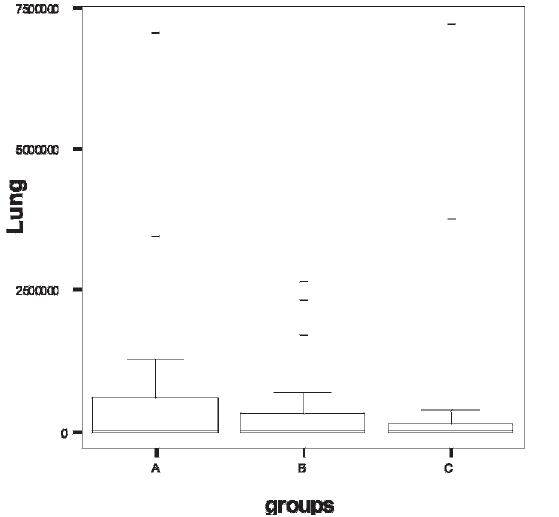
Figure 3 - Box-Plots for Peritoneum and Lung tissue cultures. Groups: A=no pneumoperitoneum, B=pneumoperitoneum, and C=pneumoperitoneum + mechanical